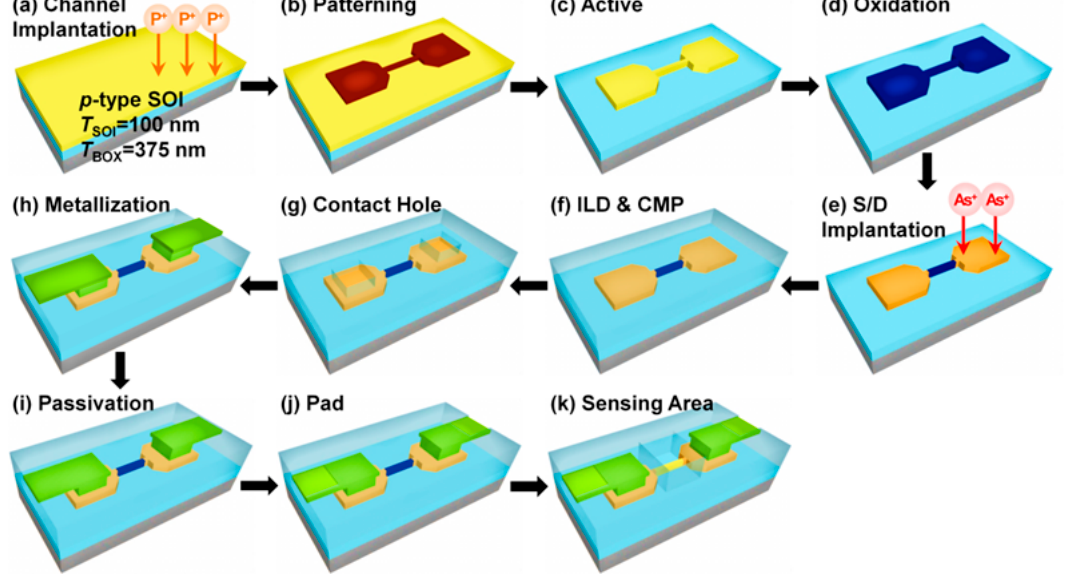
Figure 3. Schematic of the fabrication procedure for SiNW FET biosensors. A top ‐ down approach was used to fabricate the SiNW FET ‐ based influenza virus sensors.